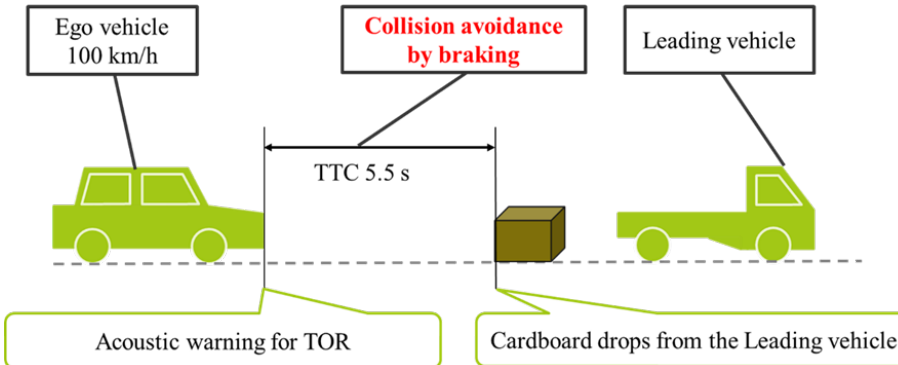
Figure 3. Takeover request (TOR) acoustic warning